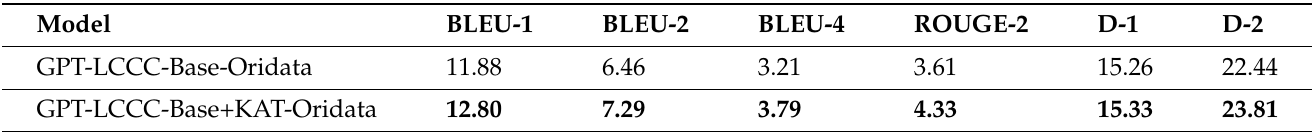
Table 5. Results on Original STC. For each evaluation metric in every column, the best result is highlighted in boldface.